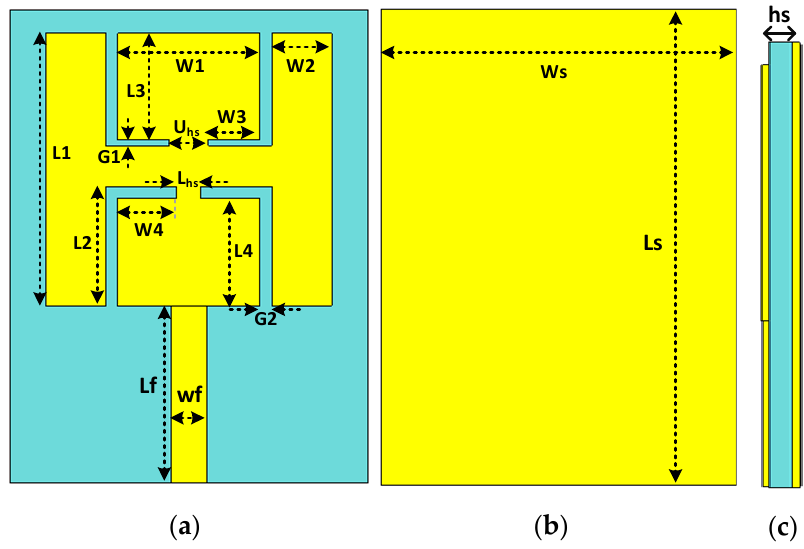
Figure 1. Antenna’s structure, ( a ) top layer, ( b ) back layer, ( c ) side view. Table 1. Optimized parameters of the proposed antenna.